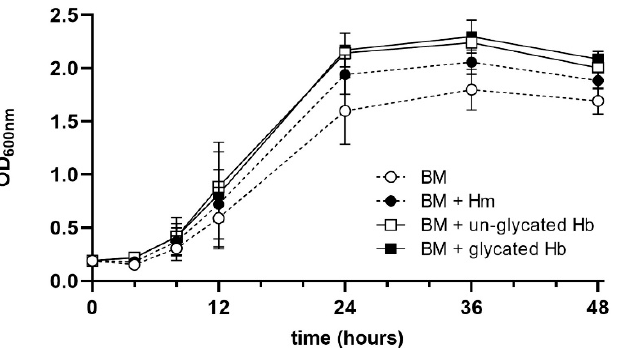
Figure 5. Analysis of P. gingivalis growth ability in liquid culture media. BM, basal medium; BM + Hm; BM supplemented with 7.7 μ M hemin; BM + Hb, BM supplemented with 2 μ M un-glycated or glycated hemoglobin; OD 600 , optical density of the culture measured at 600 nm. The data are ex- pressed as mean ± SD values from two independent experiments, each performed in two replicates.